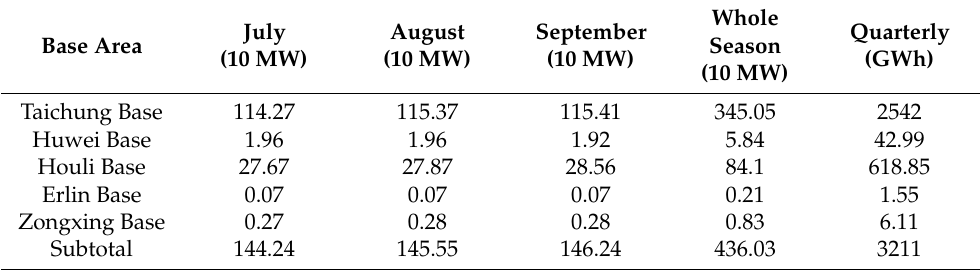
Table 6. Electricity load scale and electricity consumption in the third quarter of 2020 in Central Taiwan Science Park. The quarterly electricity consumption was calculated based on the actual working days in a particular